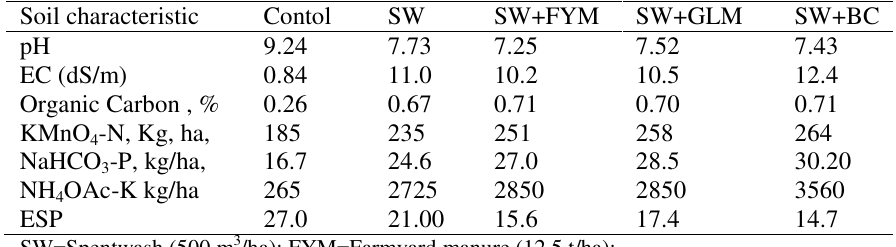
Table 1. Effect of spentwash application on selected characteristics of sodic soil. Soil